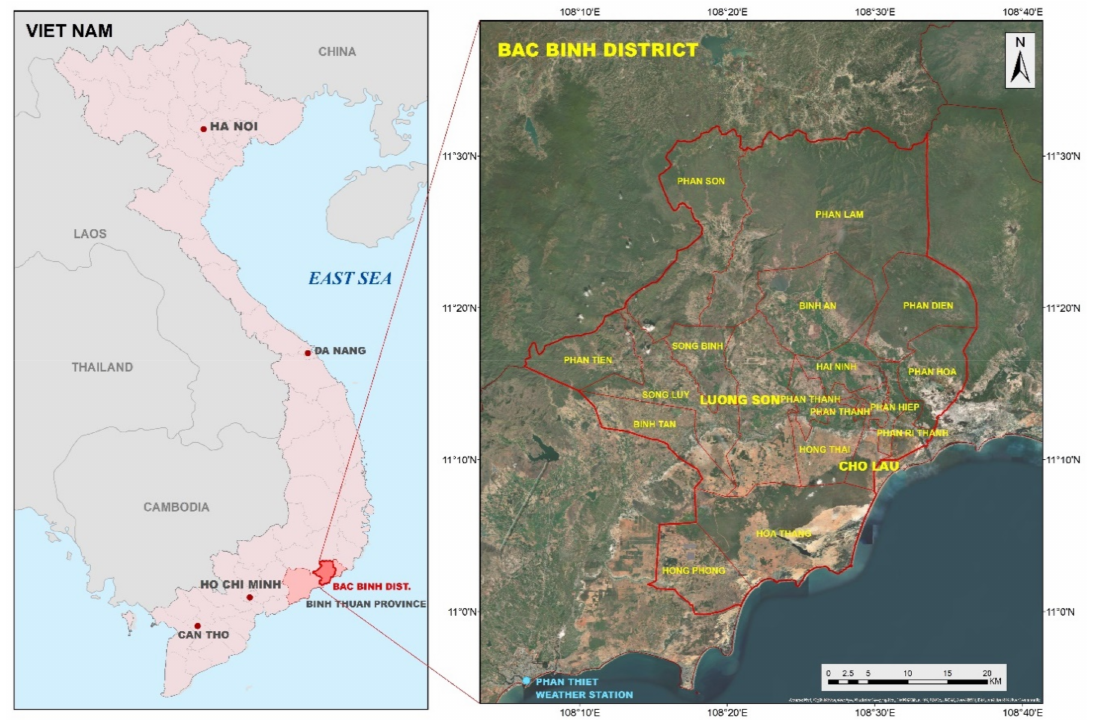
Figure 1. Study area—Bac Binh district, Binh Thuan province,